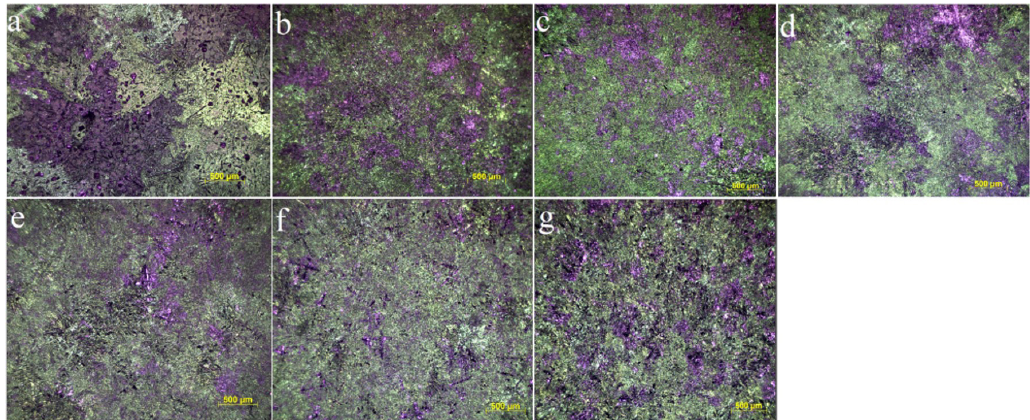
Figure 7. Al12Si1Fe”X”NbB alloy, were: a) X=0%. b) X=0.02%. c) X=0.05%. d) X=0.1%. e) X=0.2%. f) X=0.5%. g) X=1%.